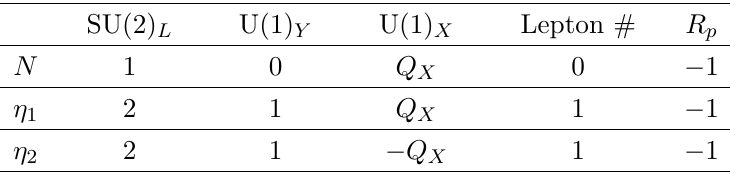
Table 1 . Representations and charged assignments of new